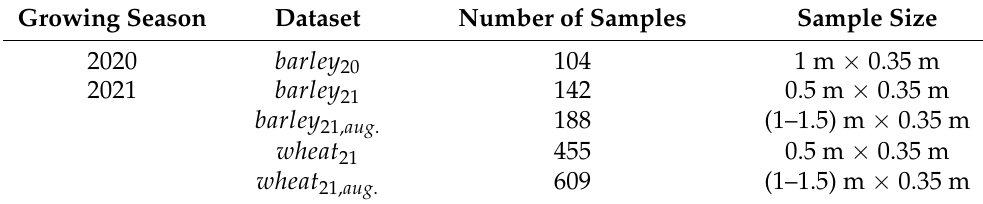
Figure 2. The crop development and canopy structure: ( a , b ) the AGB development during the 2020 (barley) and 2021 (wheat) growing seasons, respectively, with an indication of the dates of the AGB sampling events (see Table 1). The shaded area covers ± the standard deviation; ( c , d ) the crop structure at the maturity stage of the barley and wheat, respectively. Table 1. A description of the datasets. The barley 20 dataset was used for the training and validation phases, while the barley 21, aug . and wheat 21, aug . datasets were used to test the prediction